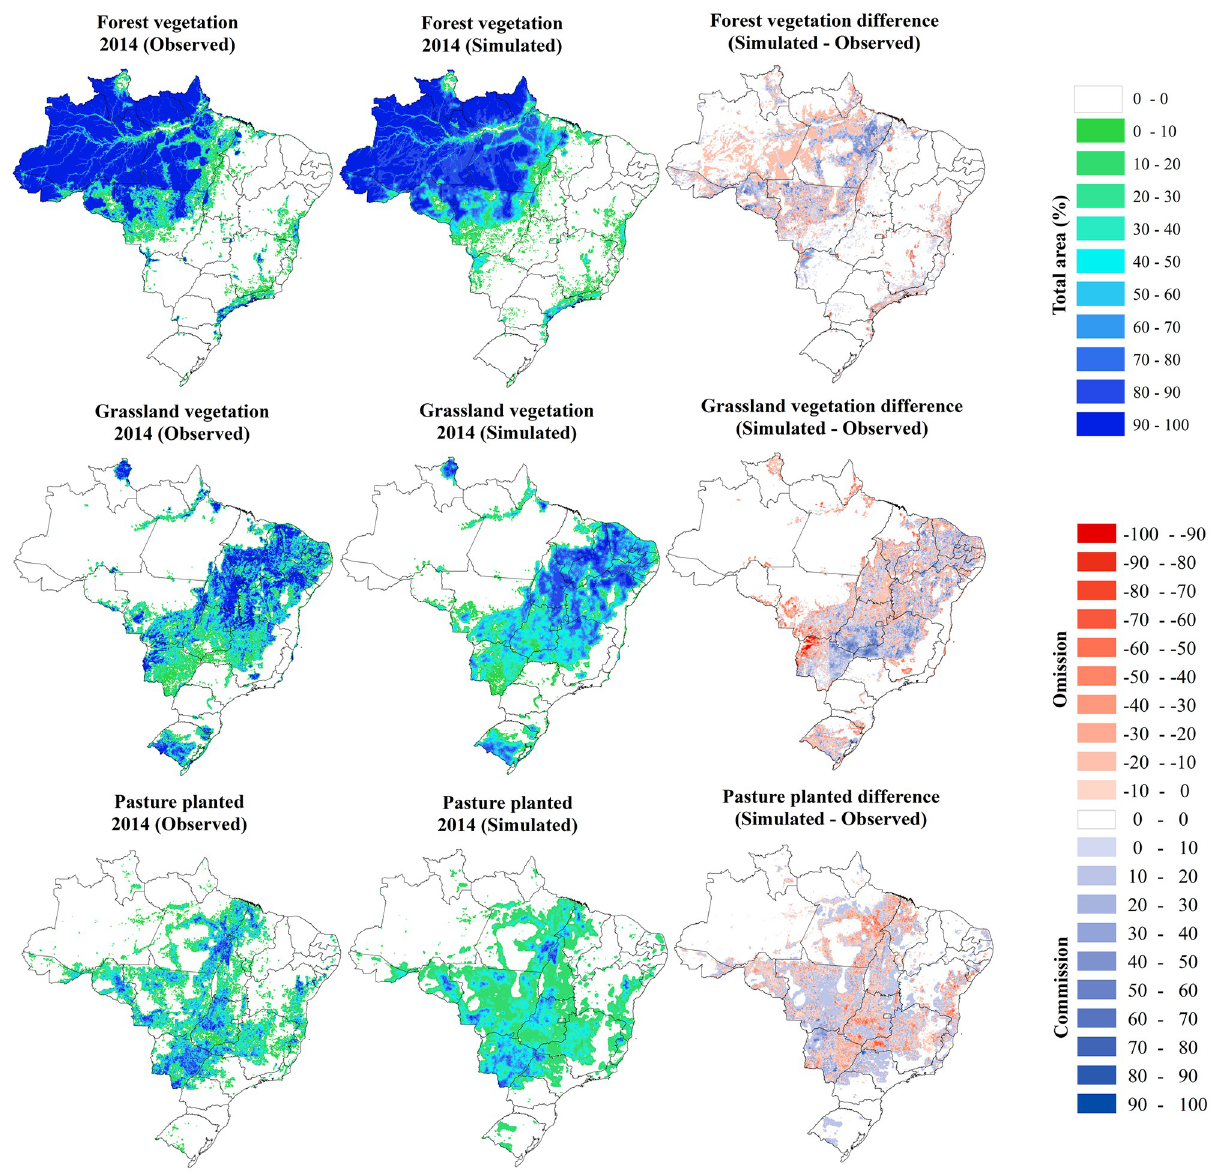
Fig 4. Percentage of forest vegetation, grassland vegetation and pasture planted observed versus simulated in 10 x 10 km 2 cells in 2014 and the spatial distribution of errors of omission and commission. The source of States boundaries is according to IBGE